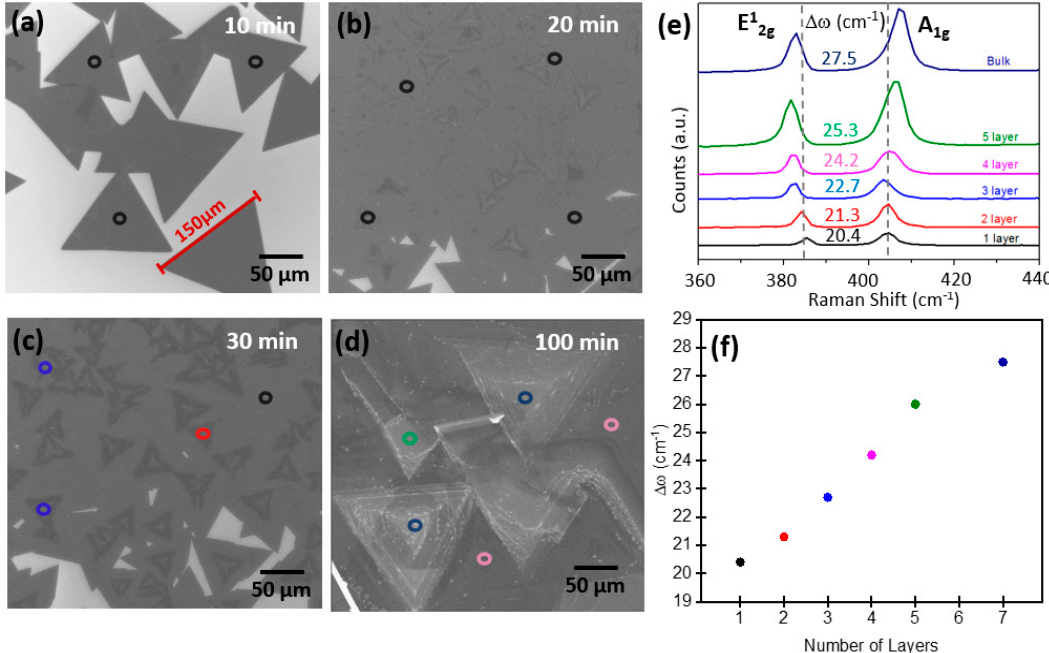
Figure 4. SEM images of obtained MoS 2 growth at different growth times: ( a ) 10 min, ( b ) 20 min, ( c ) 30 min, and ( d ) 100 min. ( e ) Raman spectra taken at different positions as shown by circular spots in the SEM images with the corresponding frequency difference between the E 12g and A 1g MoS 2 phonon modes. ( f ) Frequency difference between the A 1g and E 12g modes as a function of the number of layers.